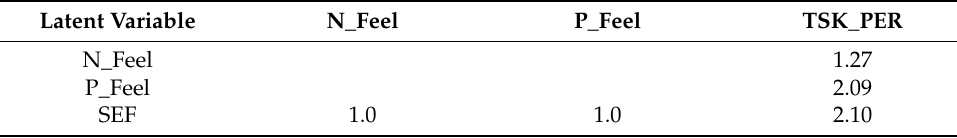
Figure 10. Measurement model results and the conceptual model of the research. Table 8. Collinearity issues evaluation with VIF